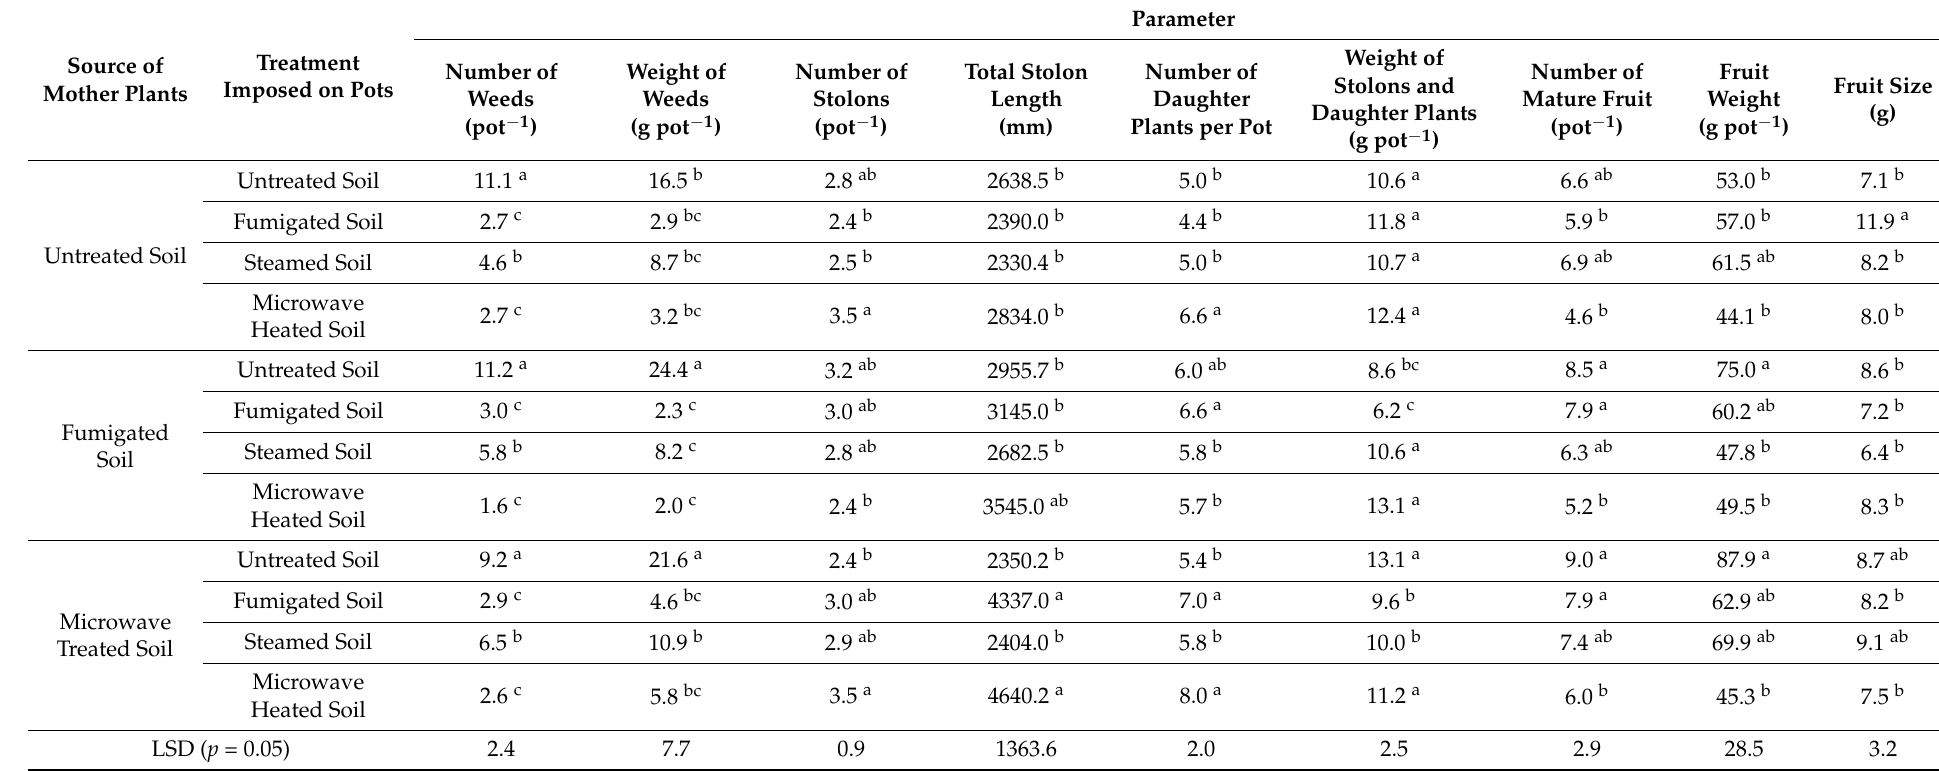
Table 6. Summary of results from a pot experiment on the on-growing of strawberry runners (Experiment